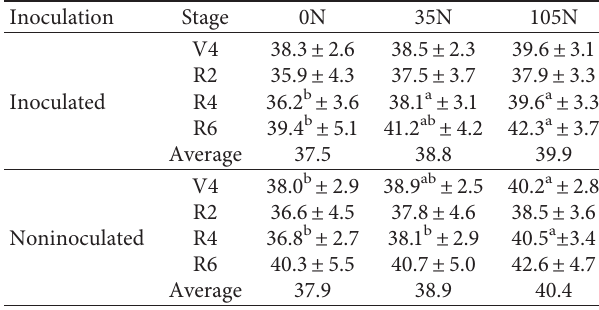
Figure 1: Irrigation amounts during the vegetative period of soybean (cv. Bogl´ar) in 2017, 2018, and 2019 in Debrecen, Hungary. NI: nonirrigated; HI: half-irrigated; FI: fully irrigated. Table 1: The effect of different fertilization rates on SPAD at different stages of soybean’s (cv. Bogl´ar) life cycle, averaged among 2017, 2018, and 2019 in Debrecen, Hungary.